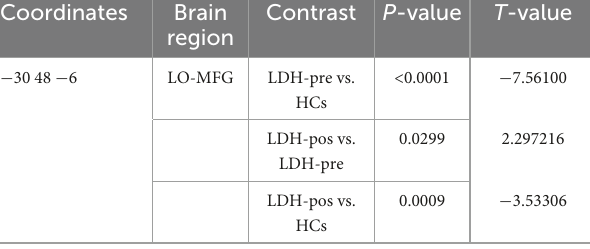
TABLE 4 Group differences in mean ReHo values. Coordinates Brain Contrast P -value T -value region − 30 48 − 6 LO-MFG LDH-pre vs. HCs